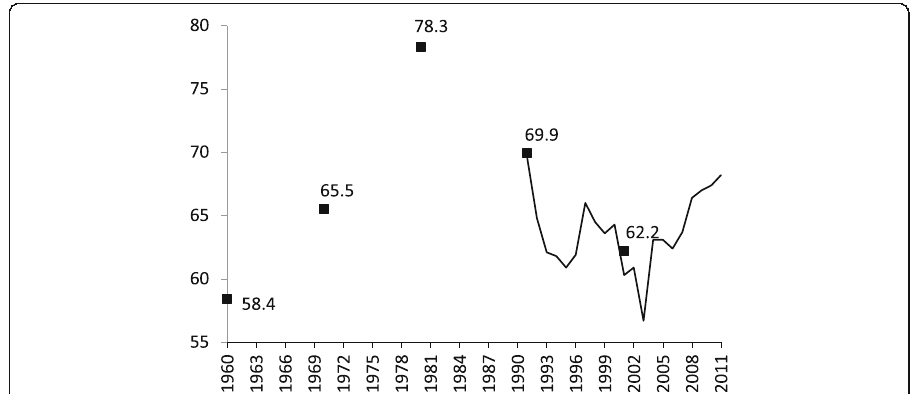
Fig. 1 Teenage fertility rate. Argentina, 1960 – 2011 (number of live births per 1000 women aged 15 – 19). Source: Data for 1960, 1970, 1980, 1991, and 2001 from Pantelides and Binstock (2007). The solid line corresponds to information provided by Office of Health Statistics